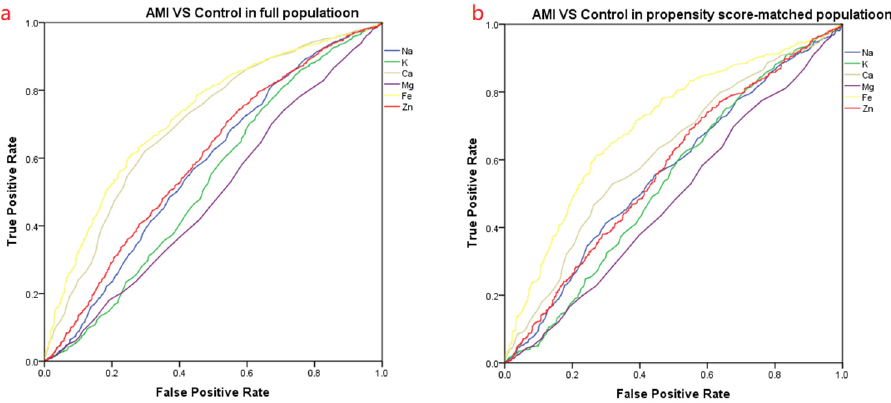
Figure 2. The ROC curve of the AMI vs. the Control group. ( a )The ROC curve before propensity score-matching. ( b ) The ROC curve after propensity score-matching. The area under the curve of the various trace elements is summarized in Table 7. Table 7. The ROC curve of the AMI vs. the SCAD